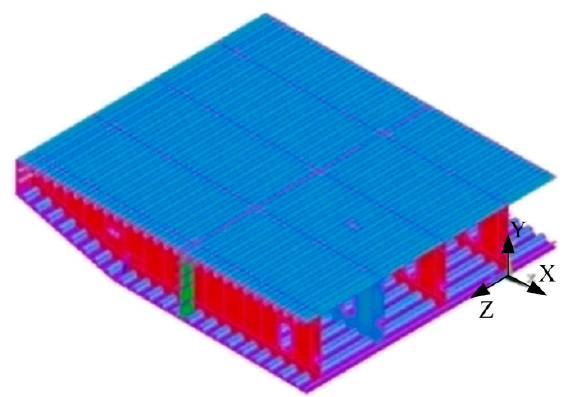
Figure 7. One-fourth finite element model of steel box girder section.